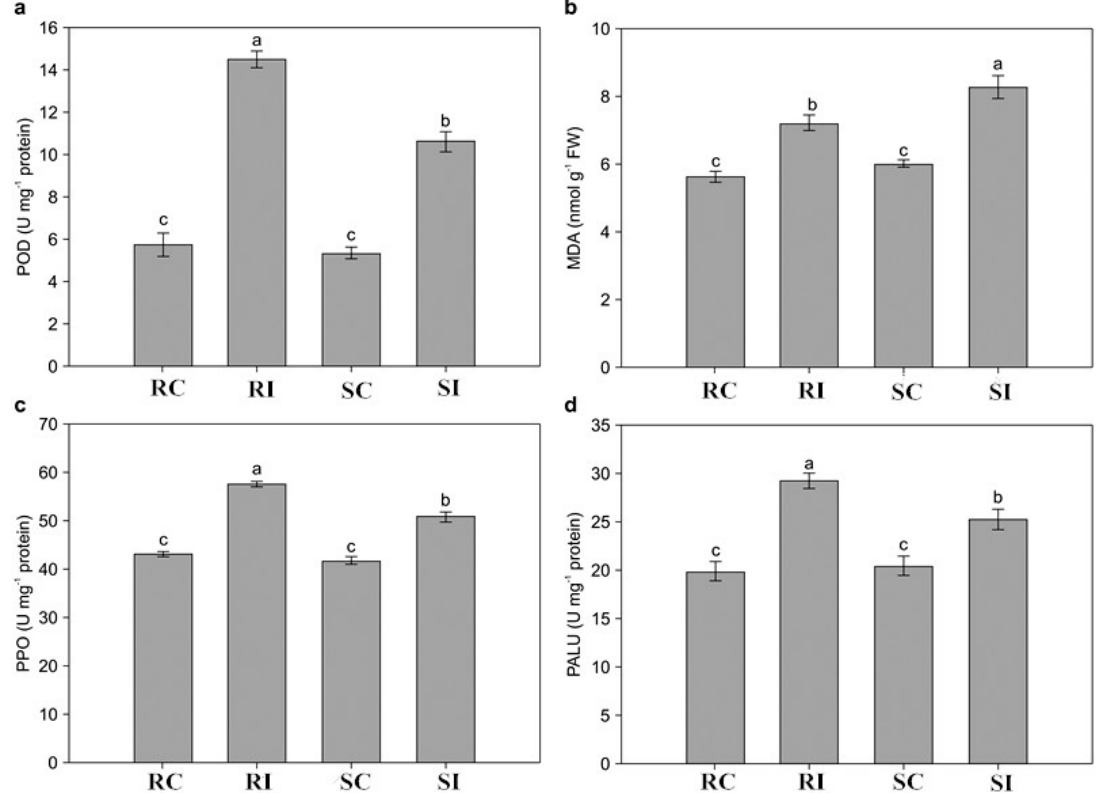
Figure 2. Changes in physiological parameters in the resistant (R) and susceptible (S) genotype in response to Meloidogyne incognita infection. Three independent experimental replicates were analyzed for each sample, and the data are presented as the mean ± SE ( n = 3). Different lowercase letters represent significant differences ( p < 0.05). POD = peroxidase; PPO = polyphenol oxidase; PAL = phenylalanine ammonialyase; MDA = malondialdehyde.